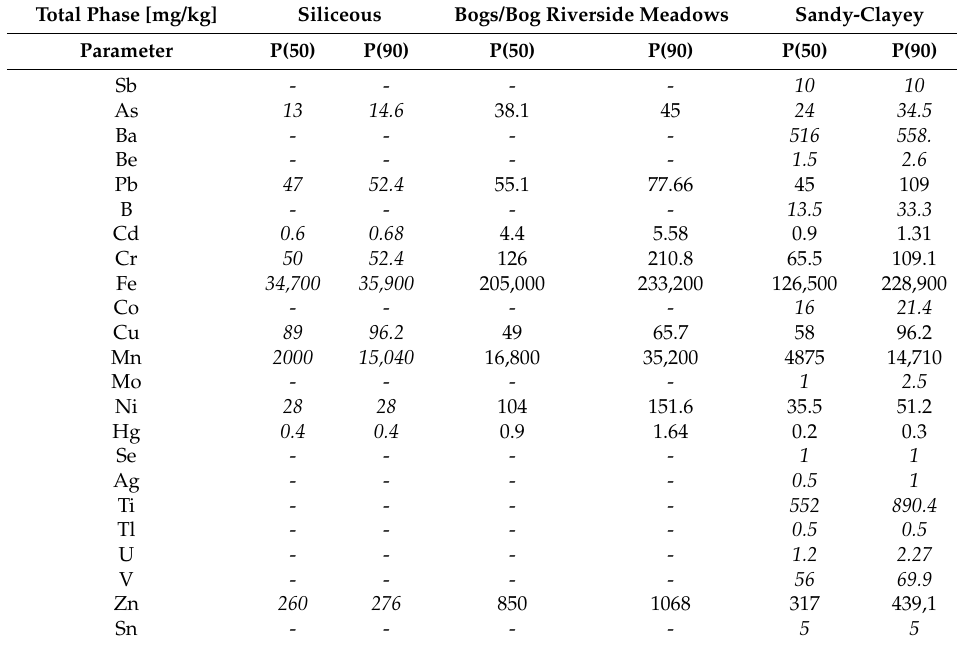
Table 4. Geogenic background concentrations of suspended particulate matter in the rivers of Saxony-Anhalt classified by the aggregated riverine landscapes (preselection of data, 50th and 90th percentiles, italics represent data below the detection